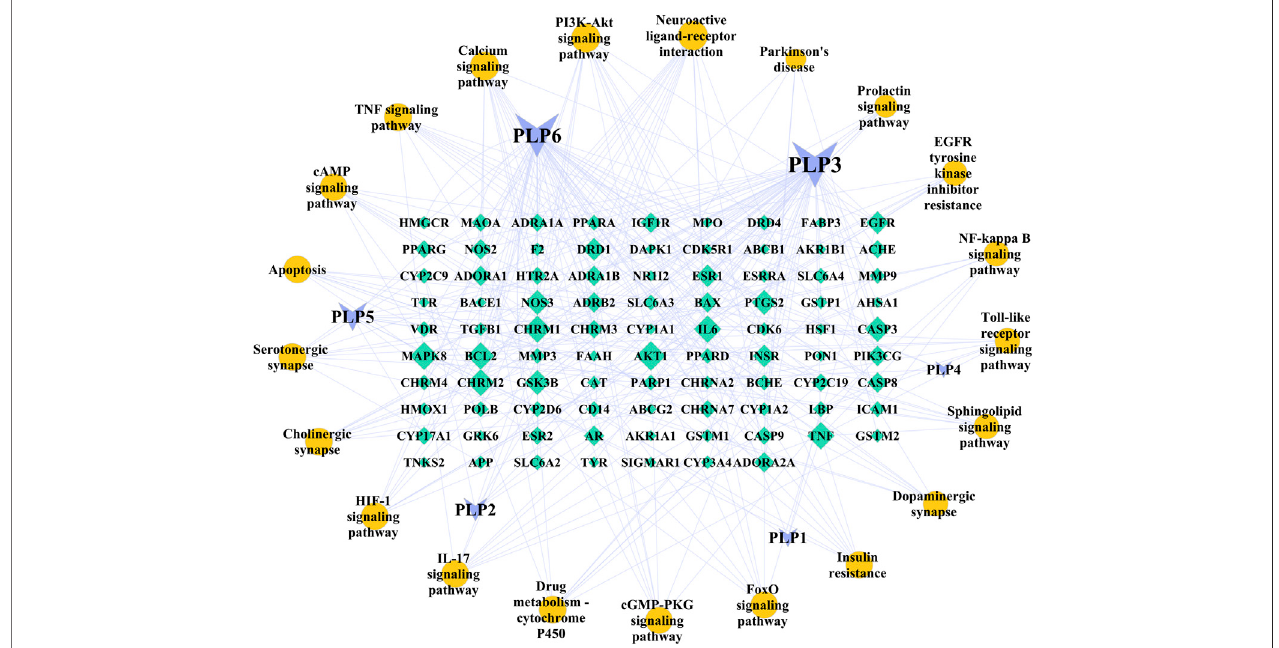
FIGURE 3 | Ingredient-Target-Pathway (I-T-P) network of Paeonia lacti fl ora P. for Parkinson ’ s disease. The purple inverted triangles represent the ingredients of Paeonialacti fl ora P.,thegreendiamondsrepresentthecommontargets,andtheyellowcirclesrepresentthemainpathways.Nodesizeisproportionaltoitsdegree.The larger the area is, the more important it is in the network. The nodes of ingredients and pathways are arranged clockwise by size. PLP1, paeoni fl orin; PLP2, palbinone; PLP3, kaempferol; PLP4, (+)-catechin; PLP5, betulinic acid; PLP6, beta-sitosterol.